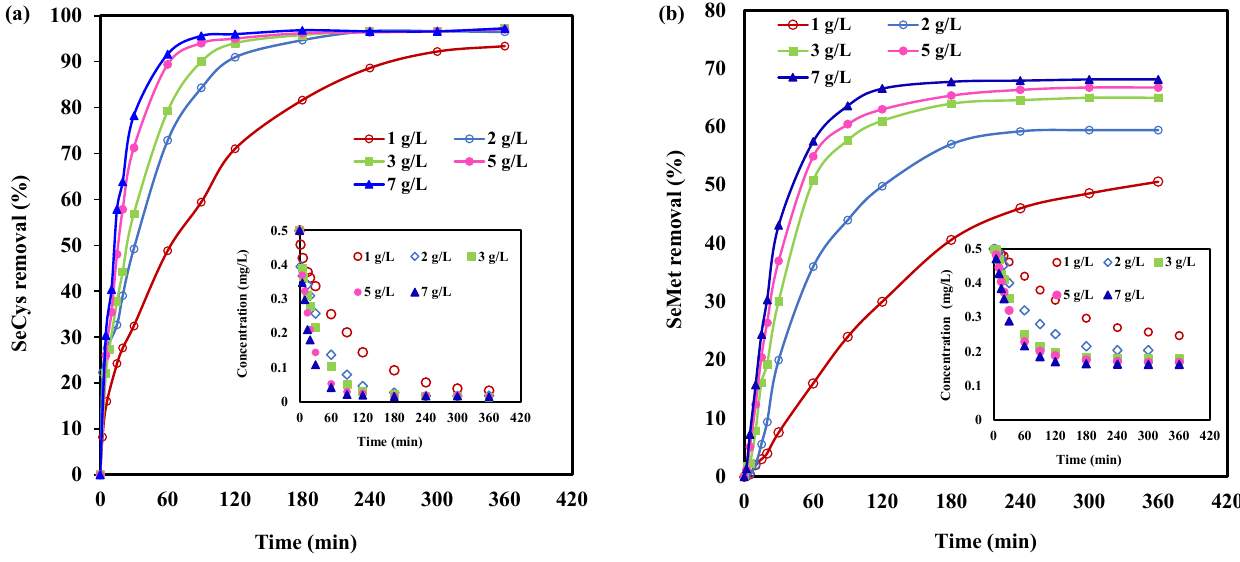
Figure 5. Dosage studies on removal of organic selenium by nZVI/GAC: ( a ) SeCys and ( b ) SeMet: (initial concentration of 0.5 mg/L, pH 7.0, at 25 °C). Contact time 6 h.